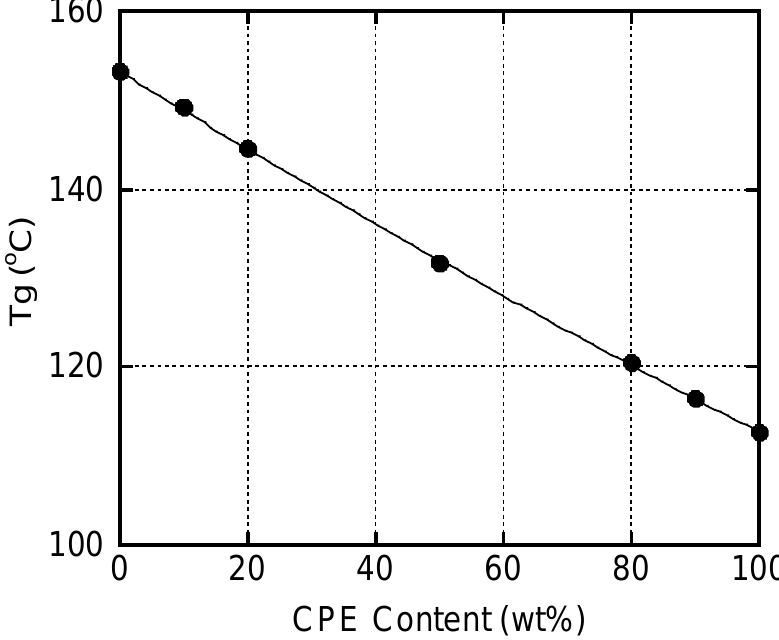
Figure 6. Relationship between T g and CPE content. The solid line represents the values calculated by the Fox equation.